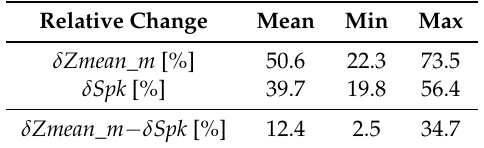
Figure 7. Graphical representation of a linear regression equation for individual grinding wheels Table 4. Selected statistical characteristics of the relative change of parameters Zmean_m and Spk as well as differences between them.